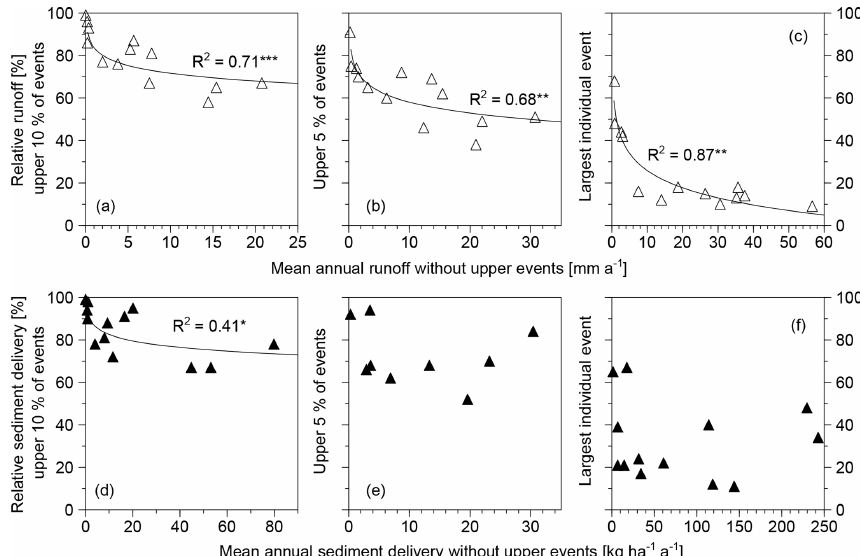
Figure 5. Relation between the upper 10% (a, d) , 5% (b, e) and the largest (c, f) surface runoff and sediment delivery events and mean surface runoff and sediment delivery in each watershed without the upper 10%, 5% or the largest events. Except for watershed W04 due to a measurement failure for the most extreme event. Insignificant regressions were